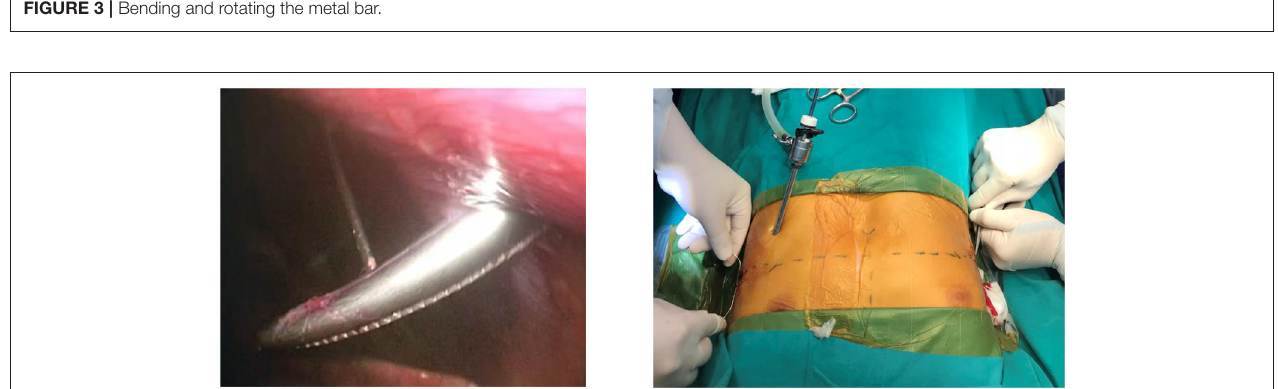
FIGURE 3 | Bending and rotating the metal bar.